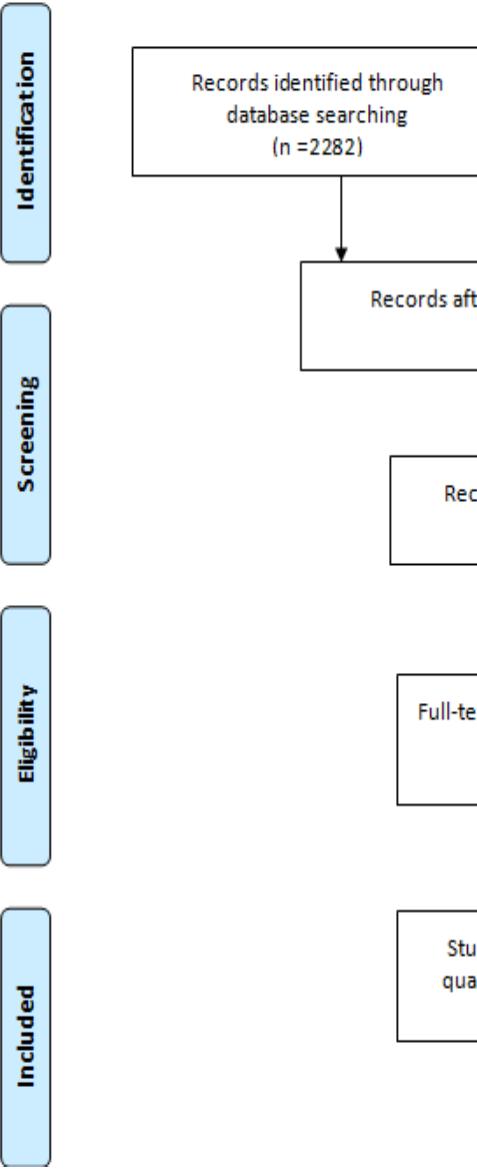
Figure 1. Flow diagram of the systematic review protocol.